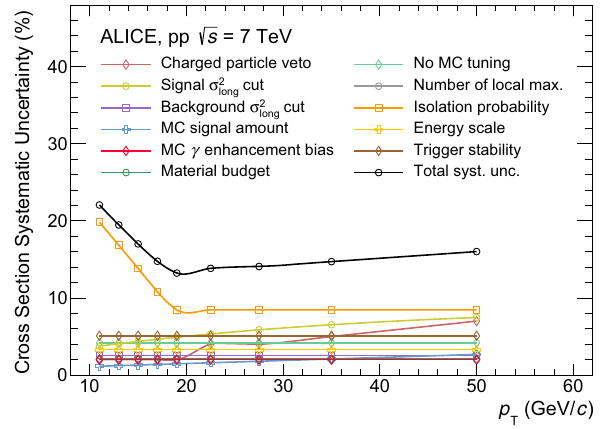
Fig. 7 Contributions to the systematic uncertainty of the isolated pho- ton cross section and their quadratic sum as a function of photon p T